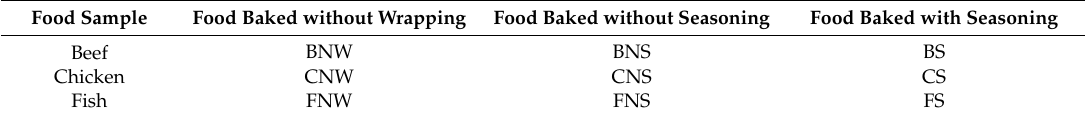
Table 1. Foods analyzed (beef, chicken, and fish): samples baked without wrapping (i.e. no wrapping, NW) with the aluminum foil (BNW, CNW, FNW, respectively); samples wrapped in the aluminum foil and baked without seasoning (BNS: beef, no seasoning; CNS: chicken, no seasoning; FNS: fish, no seasoning); samples wrapped in the aluminum foil and baked using some seasoning (BS: beef with seasoning; CS: chicken, with seasoning; FNS: fish, with